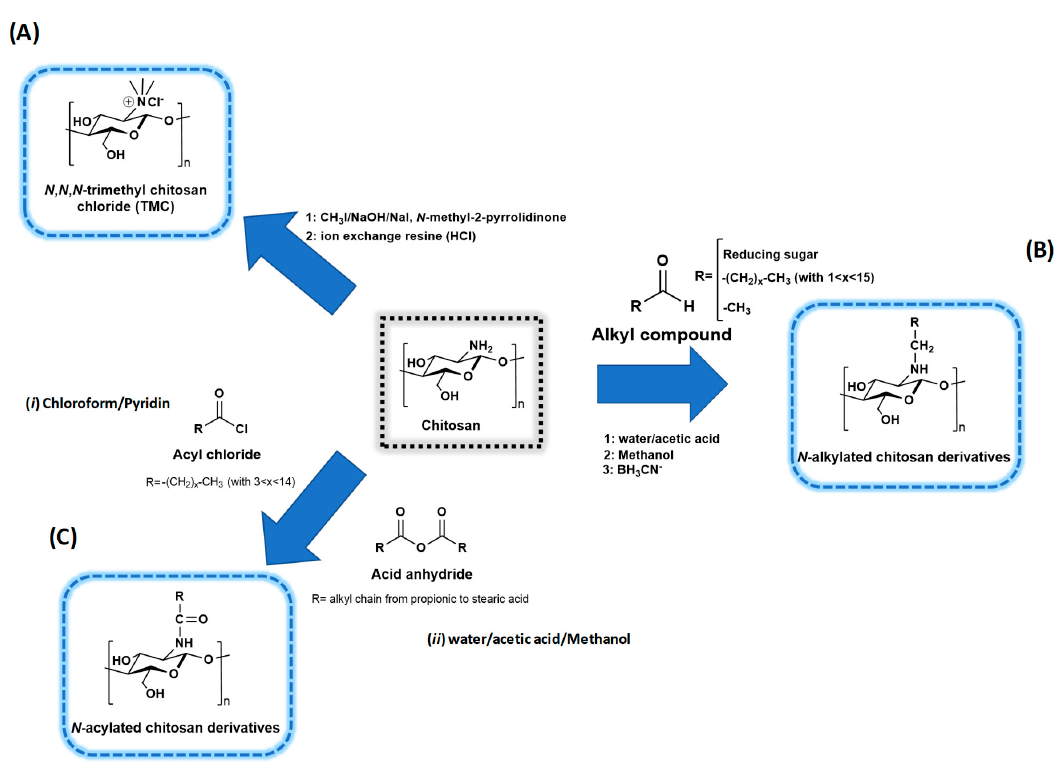
Figure 3. Production of chitosan derivatives by different methods: ( A ) Quaternization, ( B ) N-alkylation, and ( C ) N-acylation.